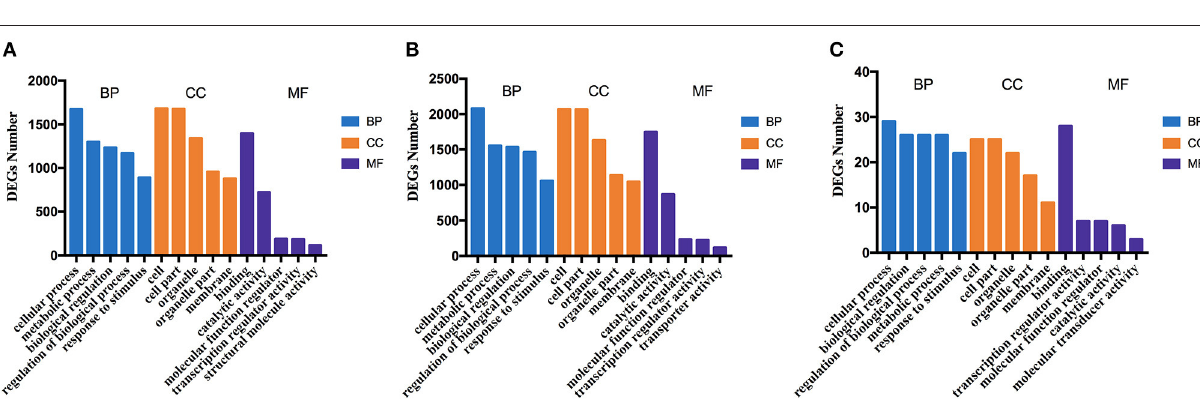
FIGURE 8 | The column diagrams for Gene Ontology (GO) analysis of DEGs. The x -axis represents the functions of GO analysis. The y -axis represents the numbers of DEGs. (A) DEGs of group TNNI2. (B) DEGs of group ACTA1. (C) DEGs of group TNNI2-ACTA1